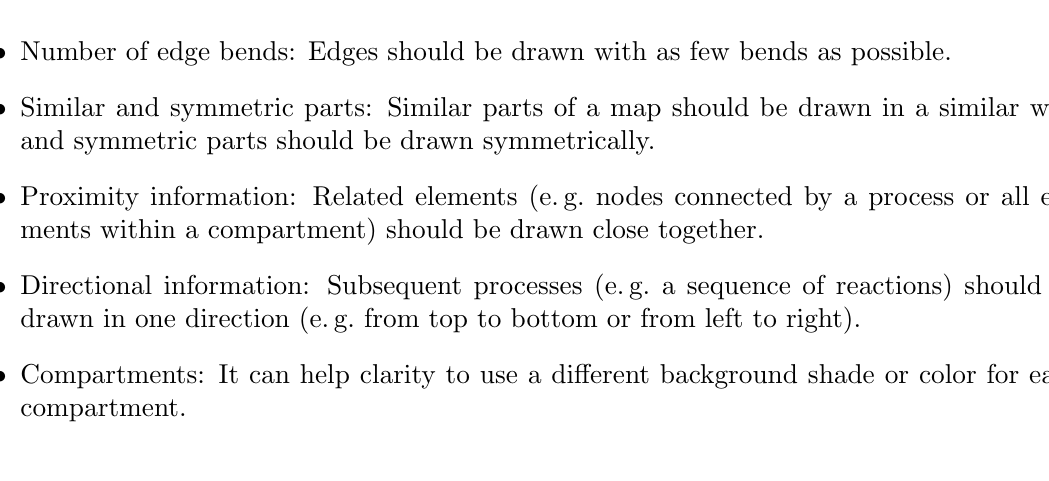
Figure 4.8: Units of information should not overlap with any other